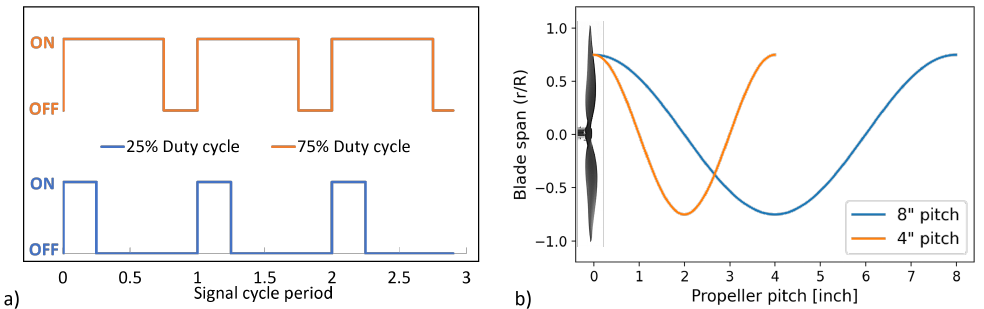
Figure 1. ( a ) 25% and 75% motor duty cycle examples. ( b ) Forward movement of 4 (cid:48)(cid:48) and 8 (cid:48)(cid:48) pitch propellers for one complete rotation.